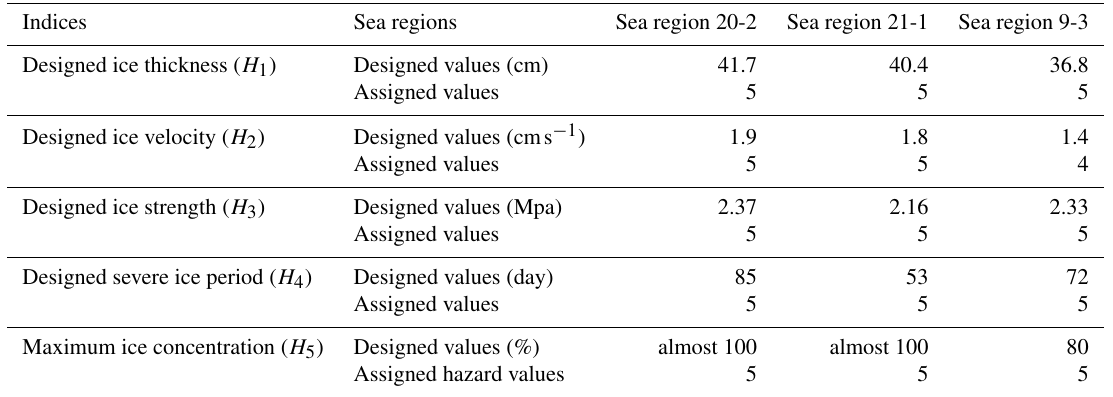
Table 11. Designed and assigned values of sea ice hazard indices in case analysis. Indices Sea regions Sea region 20-2 Designed ice thickness ( H 1